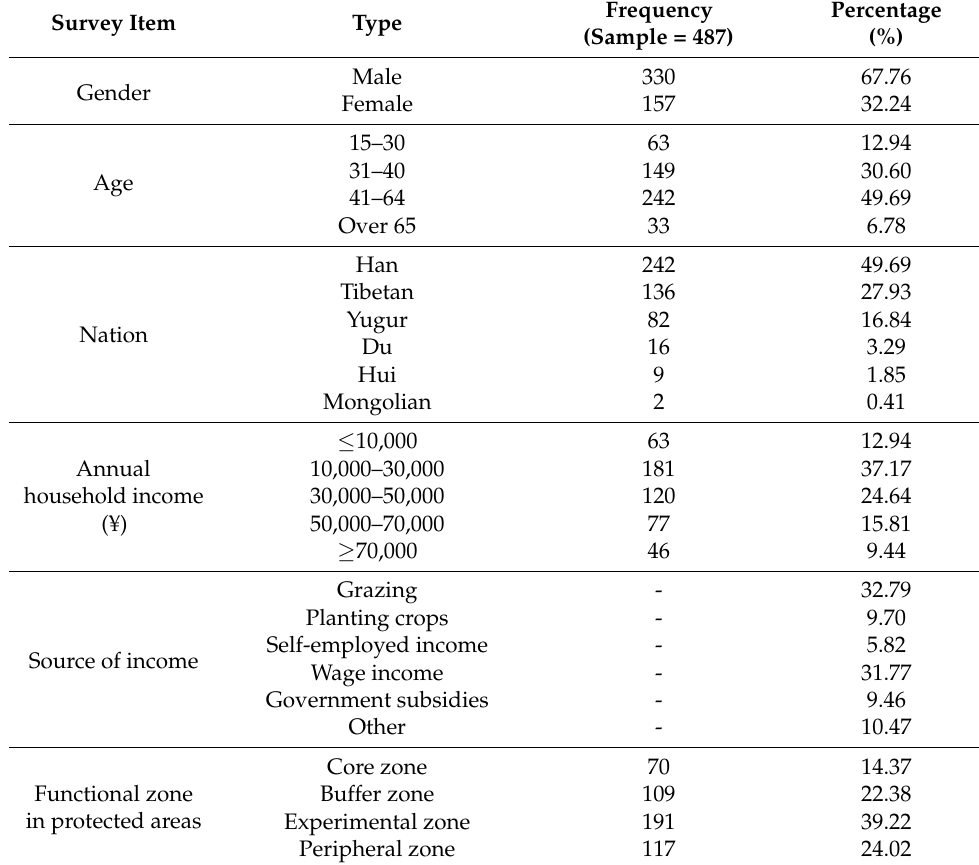
Table 2. Demographic sample.